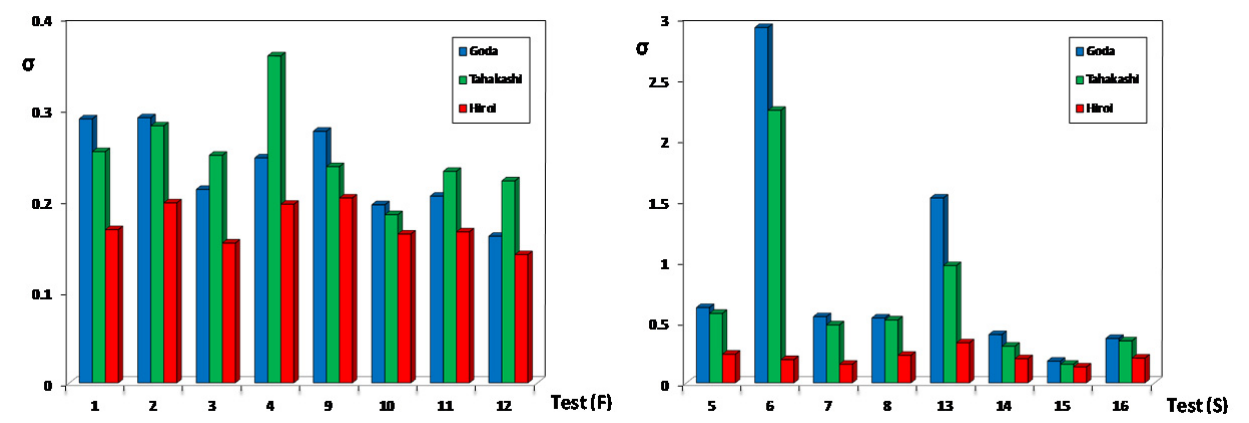
Figure 17. Standard deviation of the ratio between measured and calculated p panel: Front waves; right panel: Side